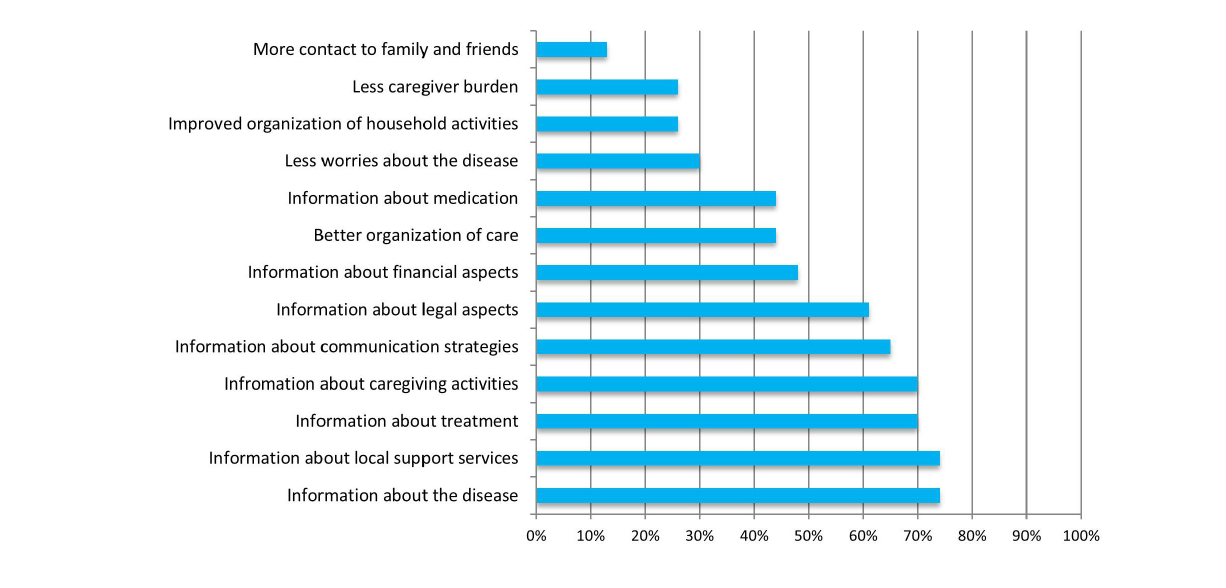
Figure 4. Empowerment via the eHM-DP (Informal caregivers,